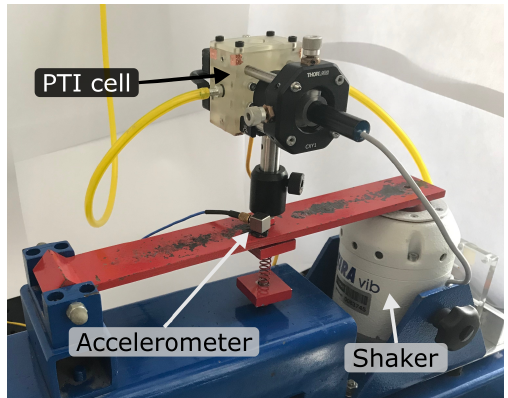
Figure 3. Photograph of the vibration test setup, showing the full photothermal interferometry (PTI) cell with gas lines and laser, mounted on an electrodynamic shaker. The piezoelectric accelerometer, measuring applied accelerations, is placed next to the cell mounting.